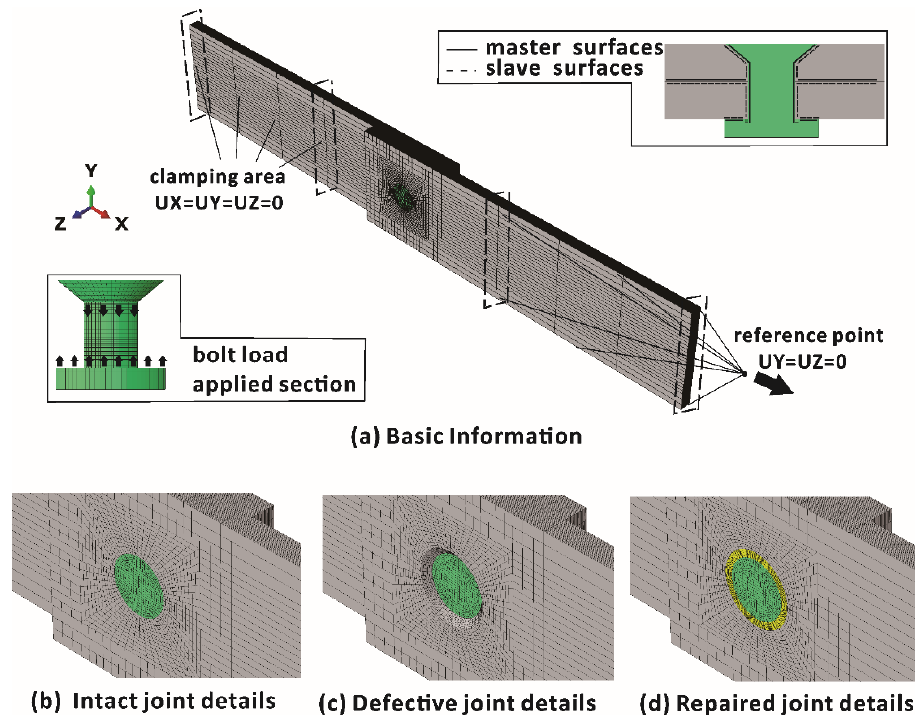
Figure 9. Finite element models: ( a ) basic information and details of ( b ) intact, ( c ) defective and ( d ) repaired samples.